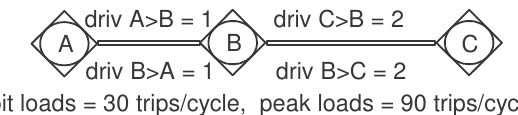
Figure 6. Calculation model with three sites